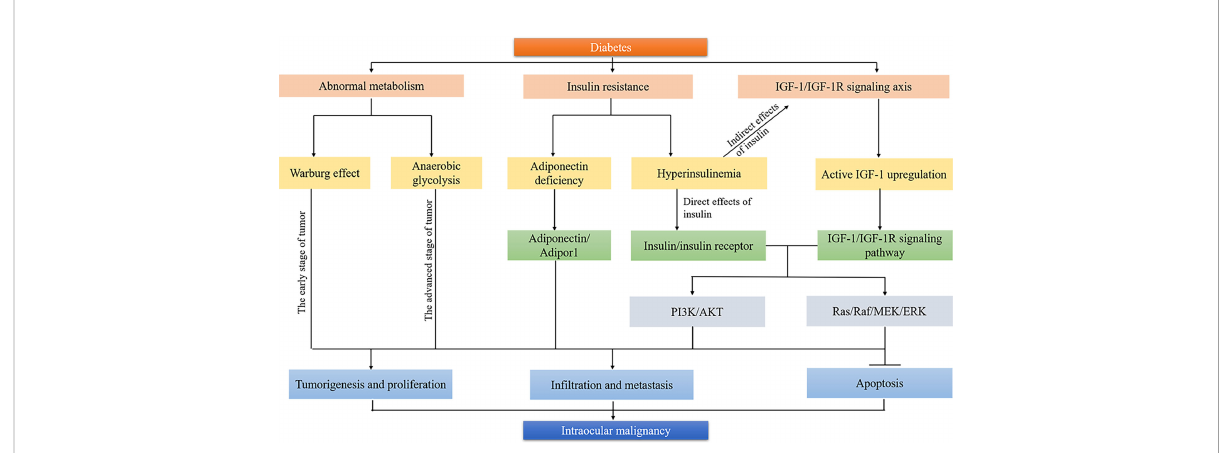
FIGURE 1 Biological mechanisms linking diabetes and intraocular malignancy. Tumor cells undergo metabolic reprogramming to meet their energy needs for rapid proliferation. Warburg effect and anaerobic glycolysis are involved in the formation and development of intraocular malignancies in the early stage and advanced stage, respectively. Insulin resistance improves carcinogenesis by developing an adiponectin-de fi cient environment, direct insulin/insulin receptor pathway, and indirect IGF-1/IGF-1R signaling pathway. Both IGF-1/IGF-1R axis and insulin/insulin receptor are involved in the occurrence and development of intraocular malignancy through PI3K/AKT and Ras/Raf/MEK/ERK signaling pathways. ! , activation; ⊥ ,